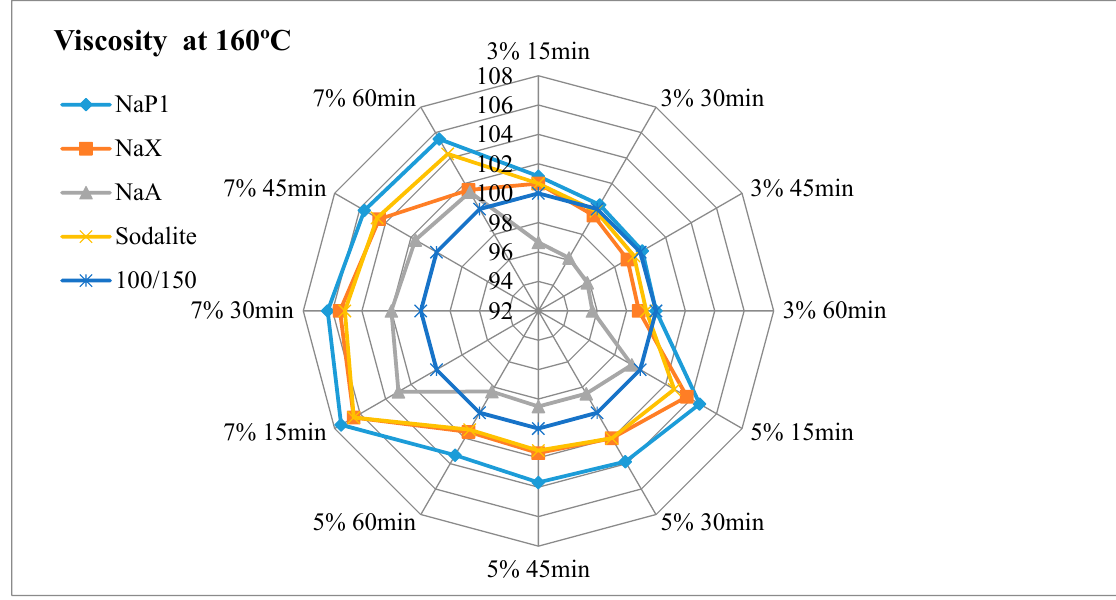
Figure 6. The results of dynamic viscosity tests for 100/150 asphalt with the addition of zeolites measured at 160 °C.